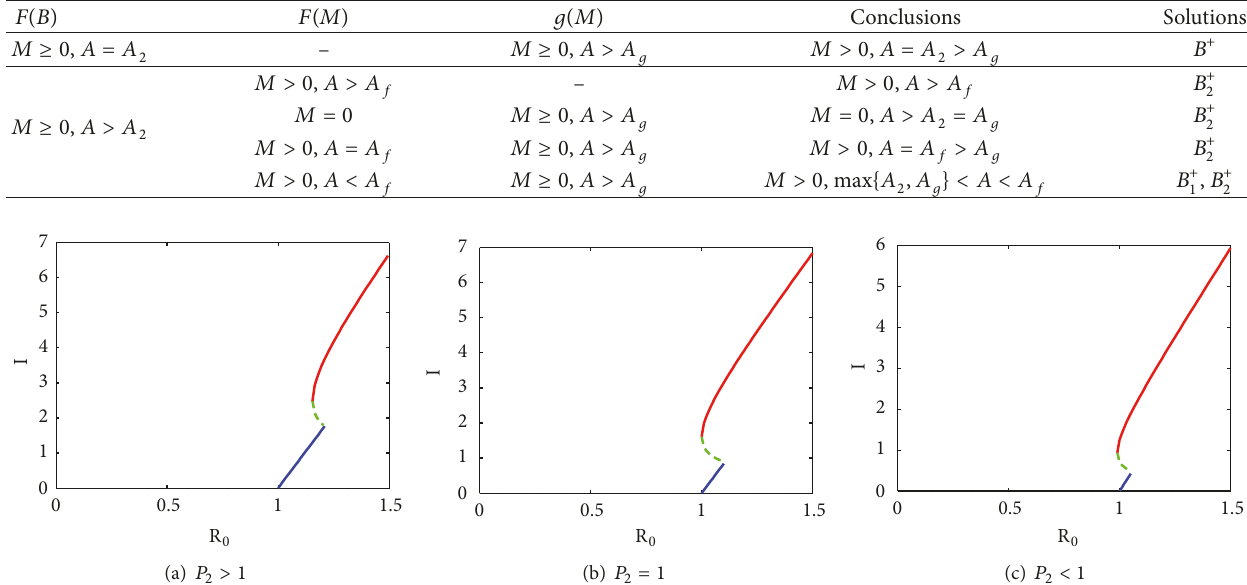
= 1 in all the pictures and the 0